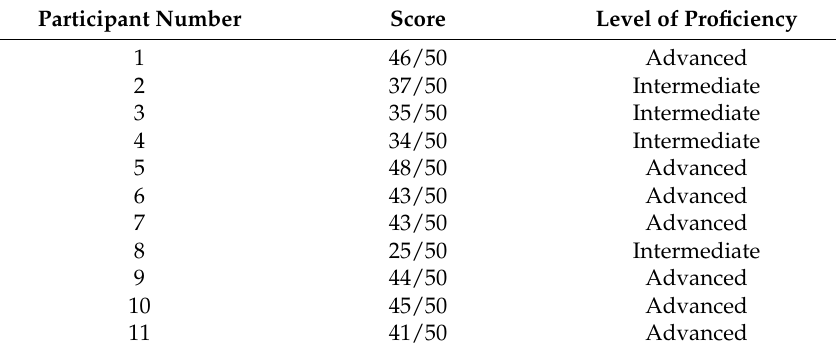
Table 1. Participants’ scores on the proficiency